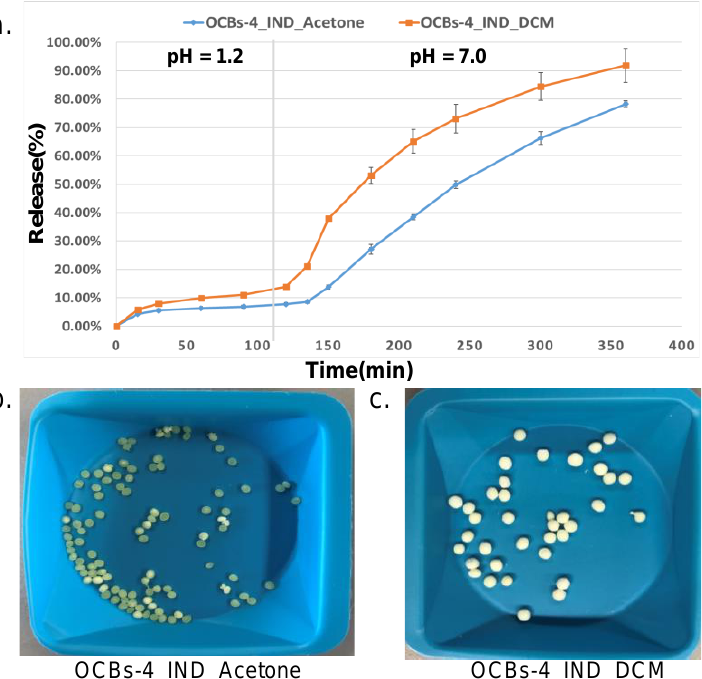
Figure 9. ( a ) Release profiles of OCBs-4_IND loaded in DCM and acetone. The results are presented as mean ± SD, n = 3. ( b ) Appearance of OCBs-4 after loading with IND in acetone and ( c ) appearance of OCBs-4 after loading with IND in DCM.